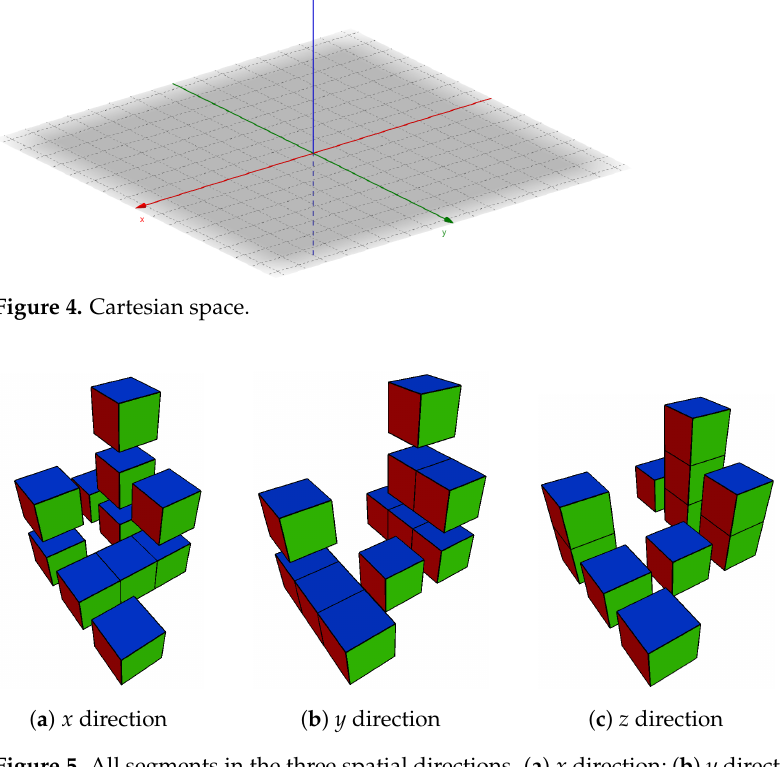
Figure 5. All segments in the three spatial directions. ( a ) x direction; ( b ) y direction; ( c ) z direction.